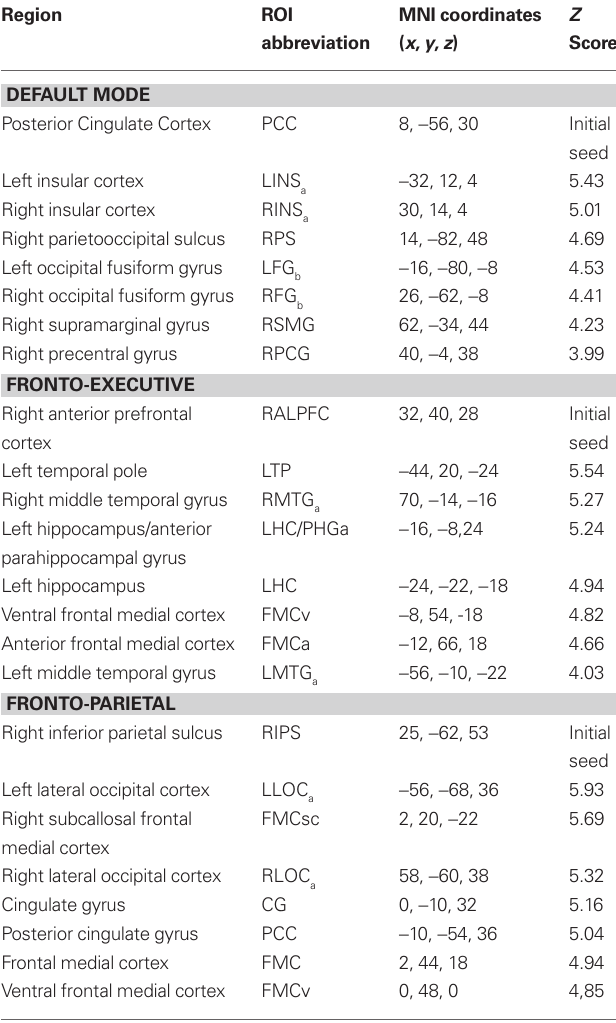
Table 4 | Regions with increased functional connectivity for Olders compared to Young adults in top-down and default mode